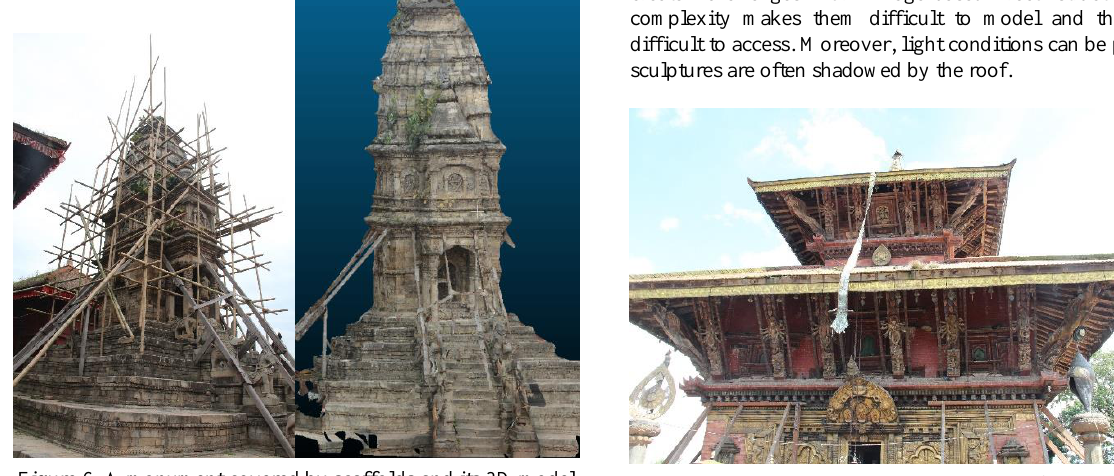
Figure 7. Changu Narayan temple imaged from the ground.